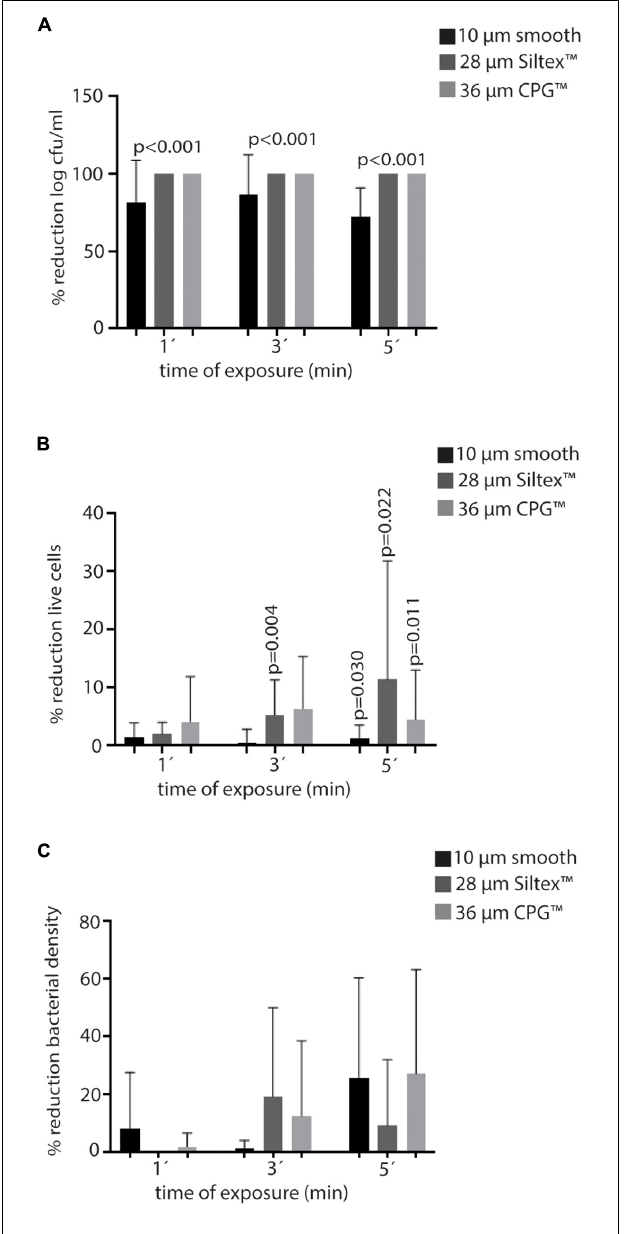
FIGURE 3 | Efficacy of PI in Mentor R (cid:13) at the three times of exposure (1 (cid:48) , 3 (cid:48) , and 5 (cid:48) ) in terms of mean percentage reduction of the variables of all Staphylococci. (A) Log cfu/ml. (B) Live cells. (C) Bacterial density. PI, povidone iodine; cfu, colony forming